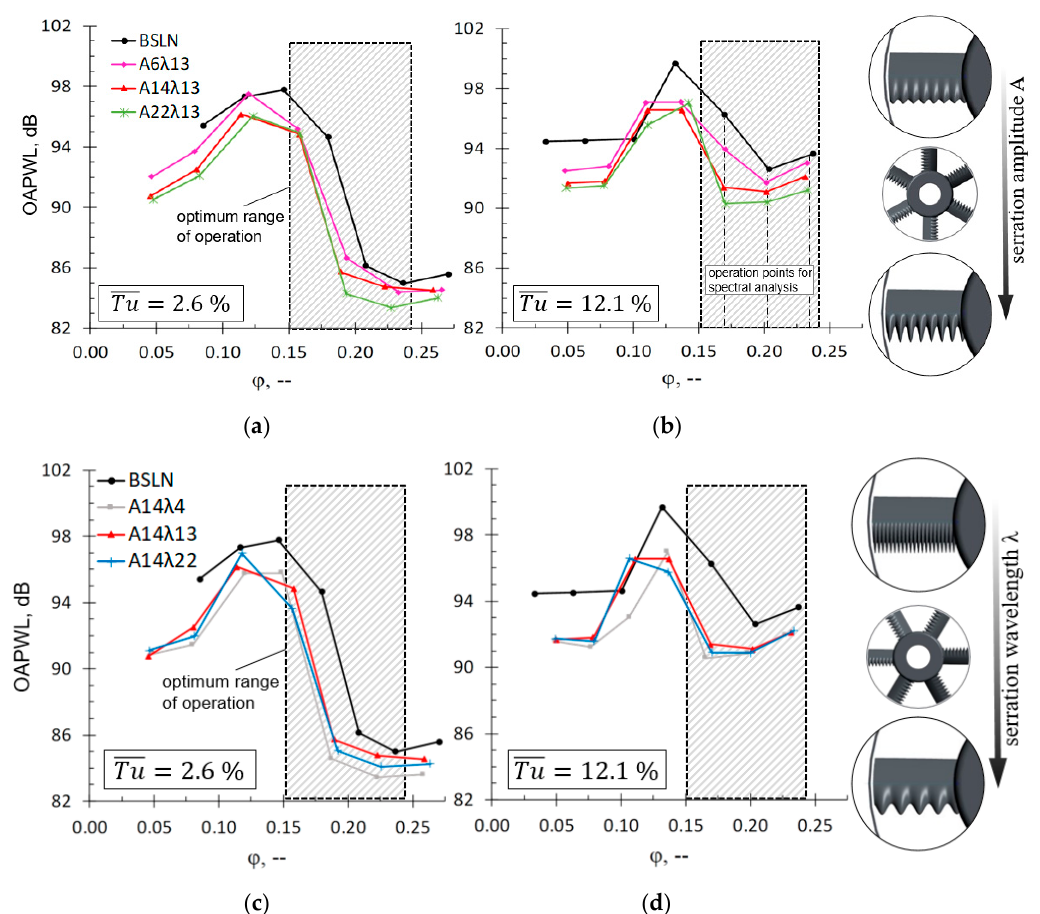
Figure 12. OAPWL of rotor equipped with leading edge serrations of varying serration amplitude, serration wavelength λ , and incoming Tu . Grey hatching indicates the aerodynamic optimum range of operation. ( a ) Varying amplitude at Tu = 2.6%; ( b ) Varying amplitude at Tu = 12.1%; ( c ) Varying wavelength at Tu = 2.6%; ( d ) Varying wavelength at Tu =